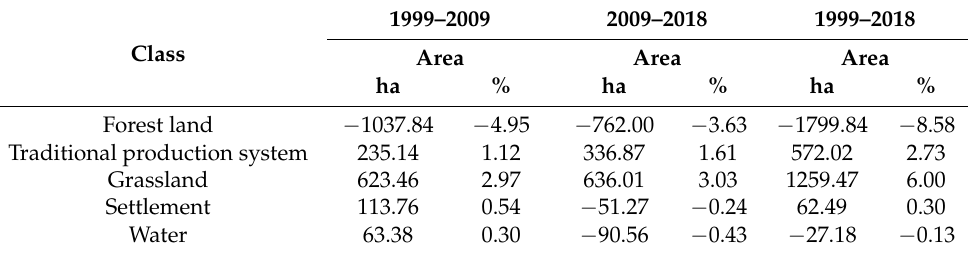
Table 5. Results of the LULC classification for 1999, 2009, and 2018 images, showing the area changed and percentages in the DLZ’s northern zone (Dayuma and Taracoa) in the Yasun í Biosphere Reserve of the Ecuadorian Amazon